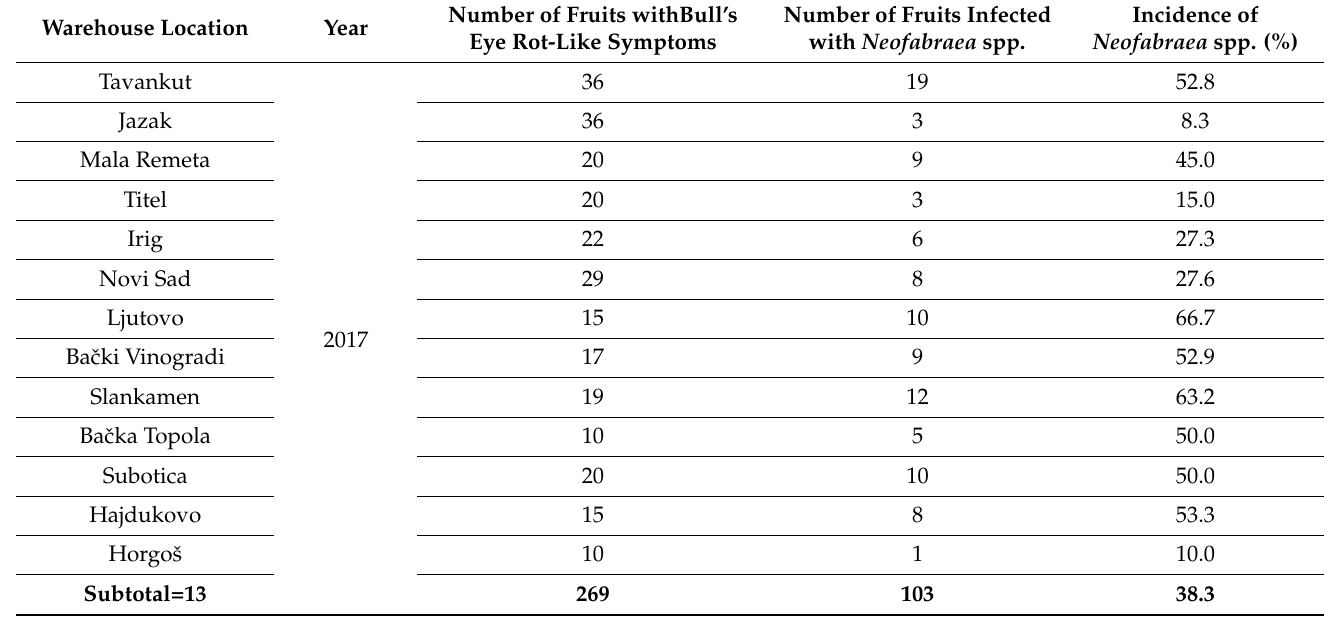
Table 2. Occurrence of Bull’s eye rot in stored apple fruit during February and March in 2017 and 2018 in northern part of